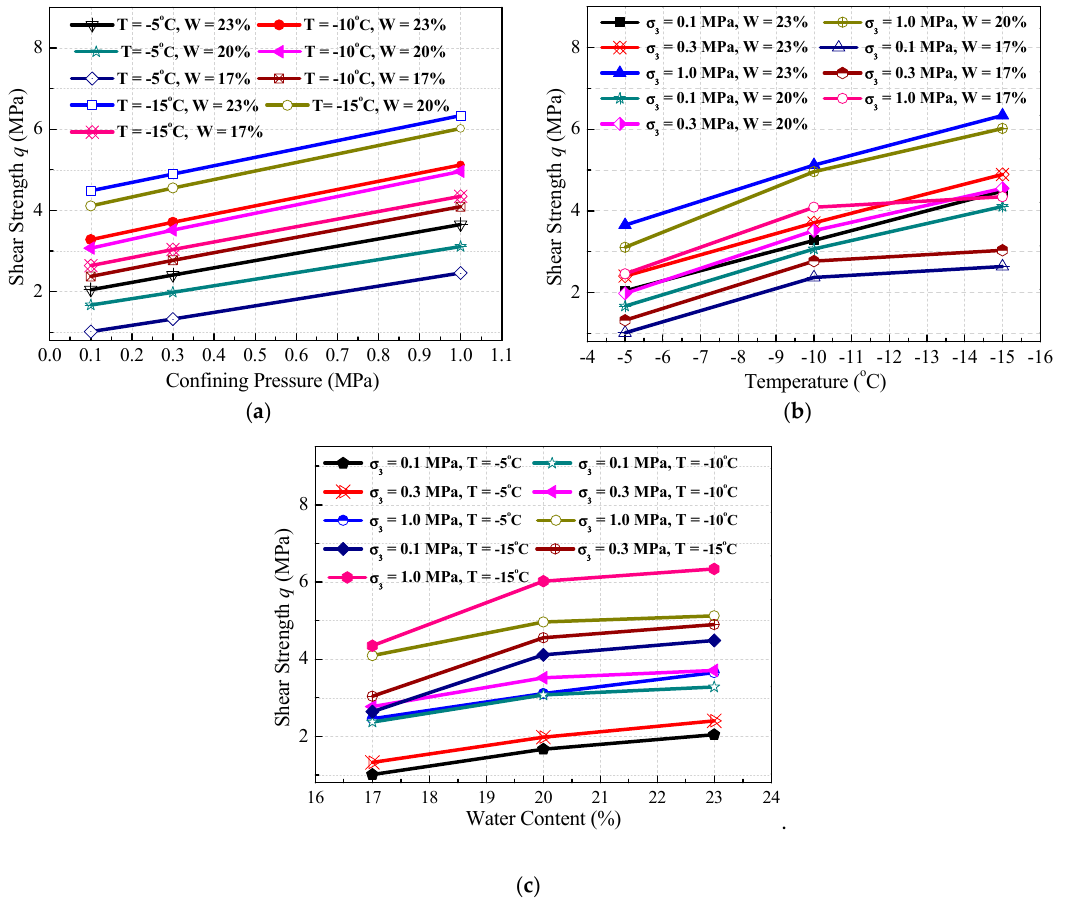
Figure 6. Shear strength varying with confining pressure ( a ), temperature ( b ), and water content ( c ).